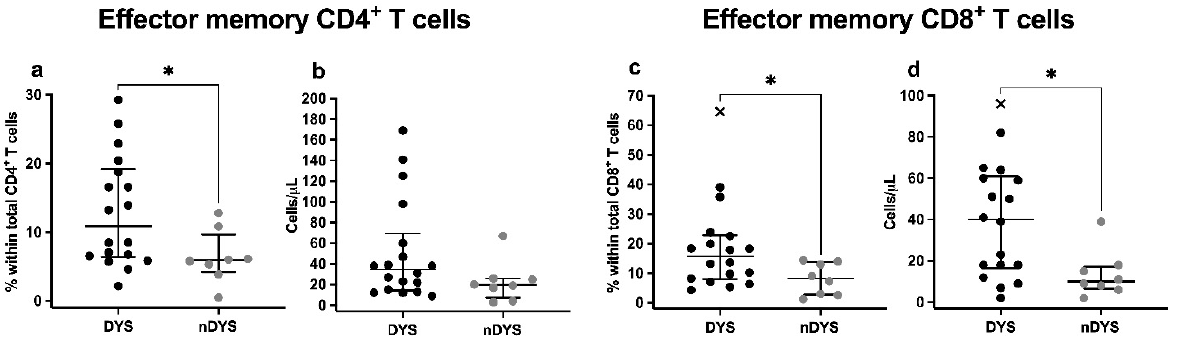
Figure 1. Median percentages or absolute counts with IQR of: ( a , b ) CD4 + Effector Memory T cells; and ( c , d ) CD8 + Effector Memory T cells, in patients with (DYS) and without (nDYS) cardiac dysfunction at admission. Differences between DYS and nDYS groups were analyzed with the Mann–Whitney test. * p -value < 0.05.